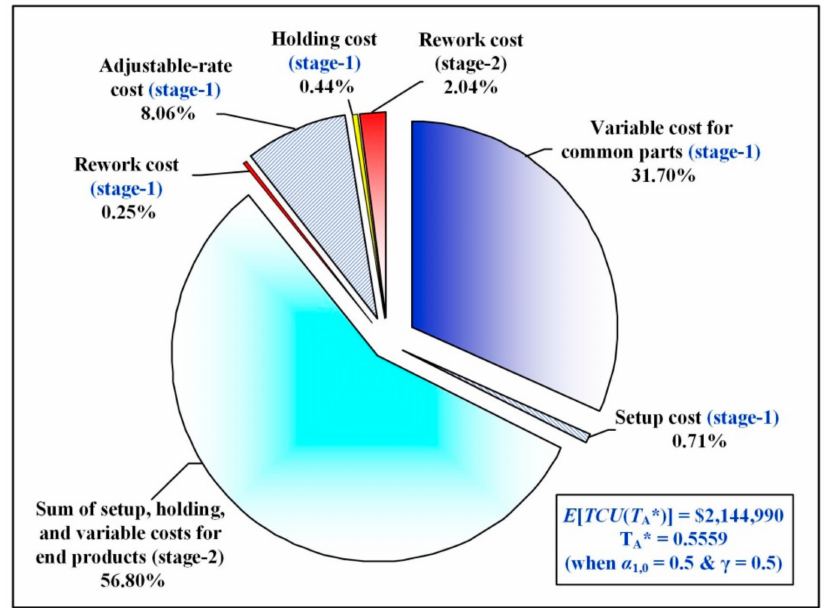
Figure 9. The breakup of E [ TCU ( T A *)].